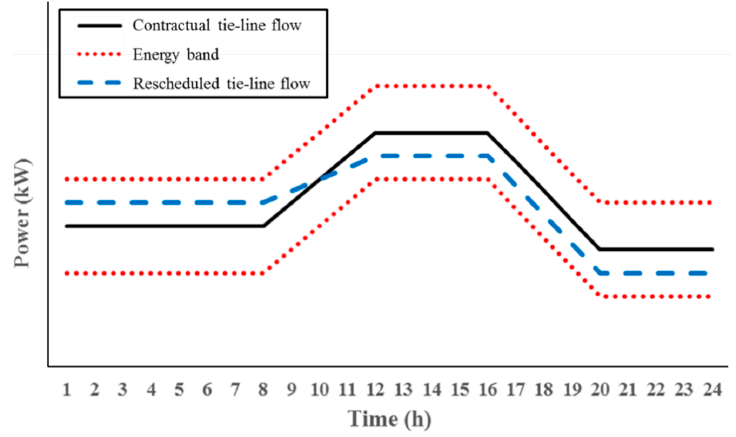
Figure 1. Energy band operational scheme.